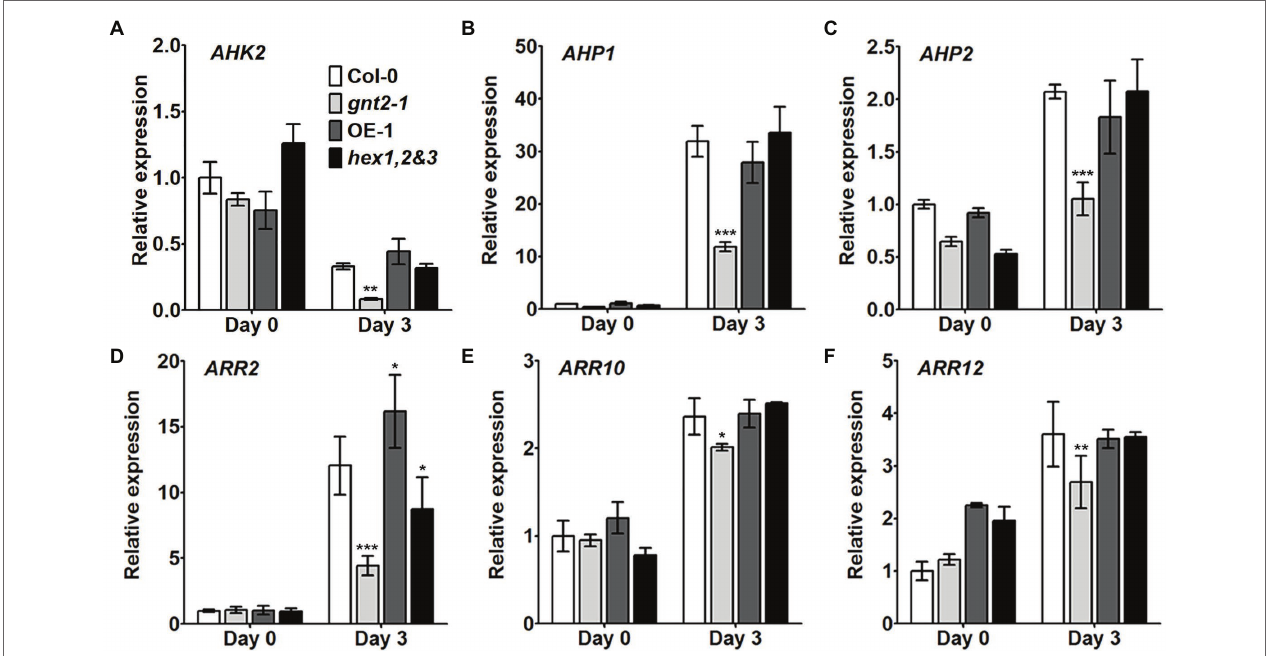
FIGURE 5 | Cytokinin signaling is impaired in the gnt2-1 mutant. (A–F) Relative expression of the cytokinin-related genes AHK2 (A) , AHP1 (B) , AHP2 (C) , ARR2 (D) , ARR10 (E) , and ARR12 (F) in leaves from Col-0, gnt2-1 , OE-1, and hex1,2&3 plants analyzed by qPCR. Total RNA was extracted from 4-week-old plants before and after 3 day of dark treatment. The experiment was performed independently three times (three biological replicates) and normalized with respect to β -TUBULIN expression. Data represent mean ± SEM of three independent experiments. Asterisks indicate statistically significant differences (* p < 0.05, ** p < 0.01, and *** p < 0.001) as determined by two-way